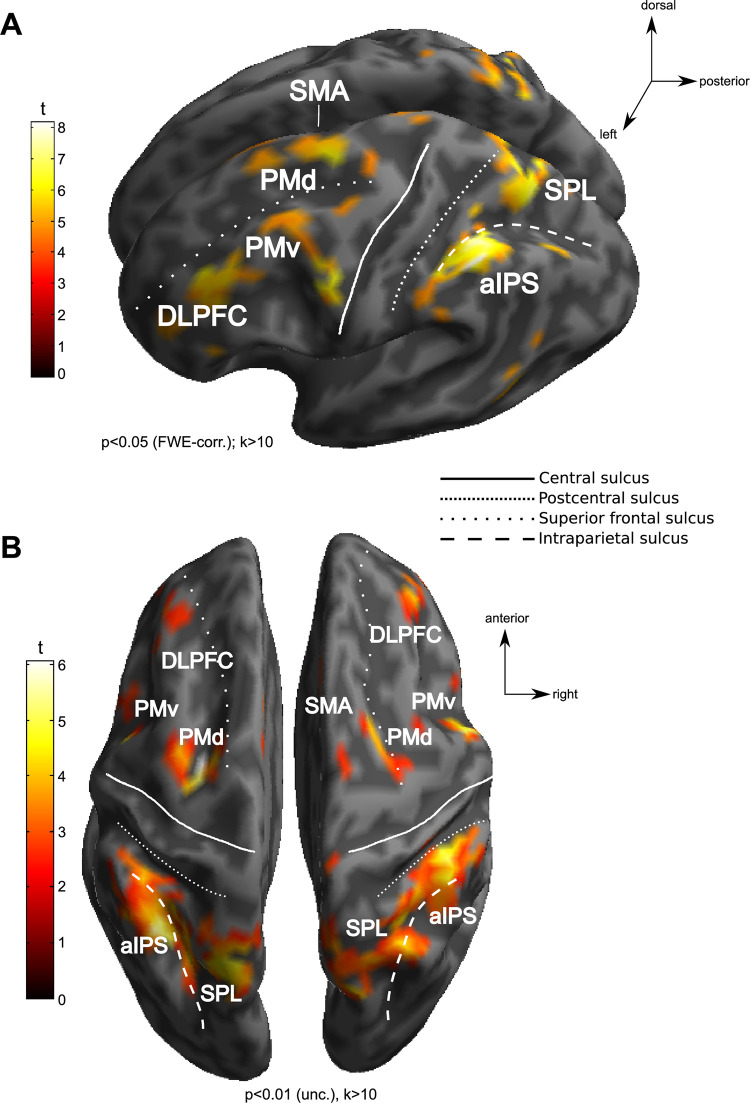
Working memory areas.The figures depict WM areas exhibiting stronger activity in M2ST than in CT during the delay period. A) depicts an exemplary subject’s WM contrast map. Such individual maps were used to functionally define our WM ROIs. B) depicts the WM contrast map of a corresponding random-effects group analysis.